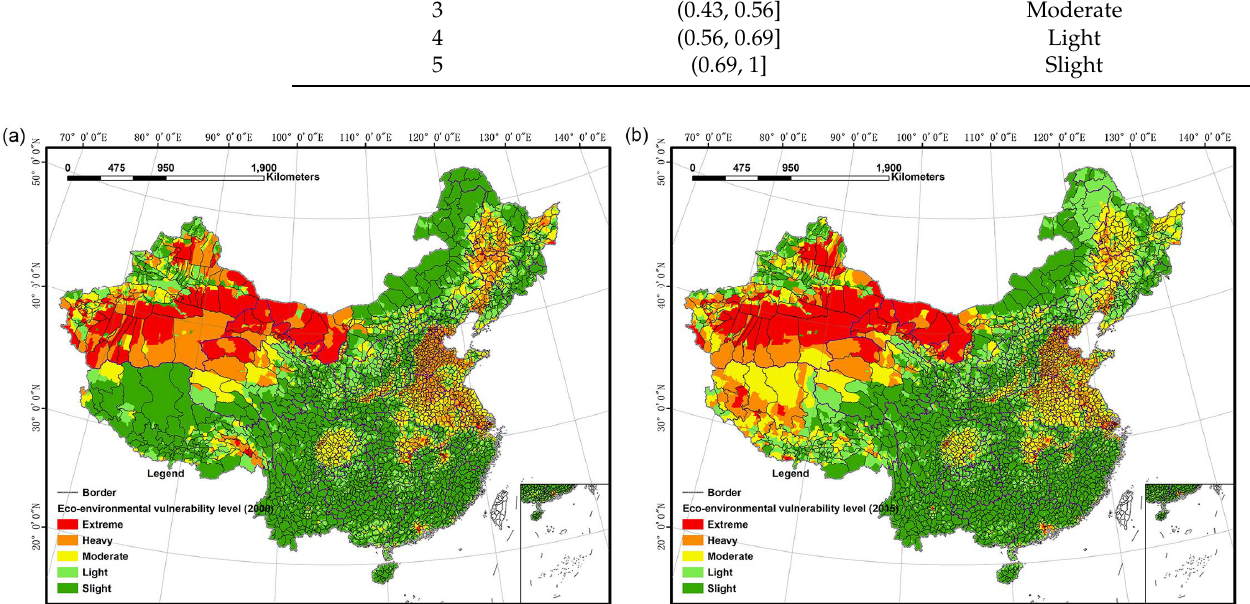
Figure 5. Eco–environmental vulnerability at the rural–area level in ( a ) 2000 and ( b ) 2015 shown at the county level representing the administrative units.